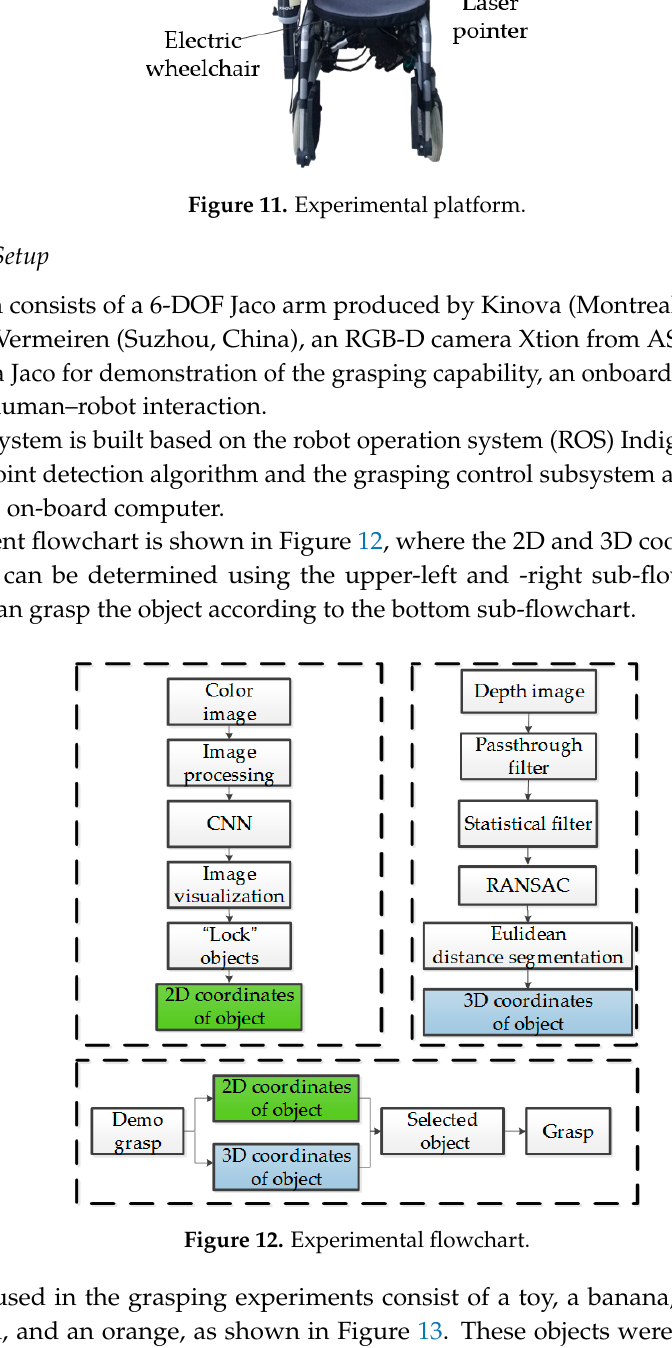
Figure 13. Photograph of experiment objects. 4.2. Experiment Results An example of a visualization is shown in Figure. 14; before the mouse is “locked”, its frame color is yellow (see Figure 14a), after which its frame color changes to blue (see Figure 14b). ( a ) Yellow before being “locked” ( b ) Blue after being “locked” Figure 14. Frame colors of the mouse before and after being “locked”.